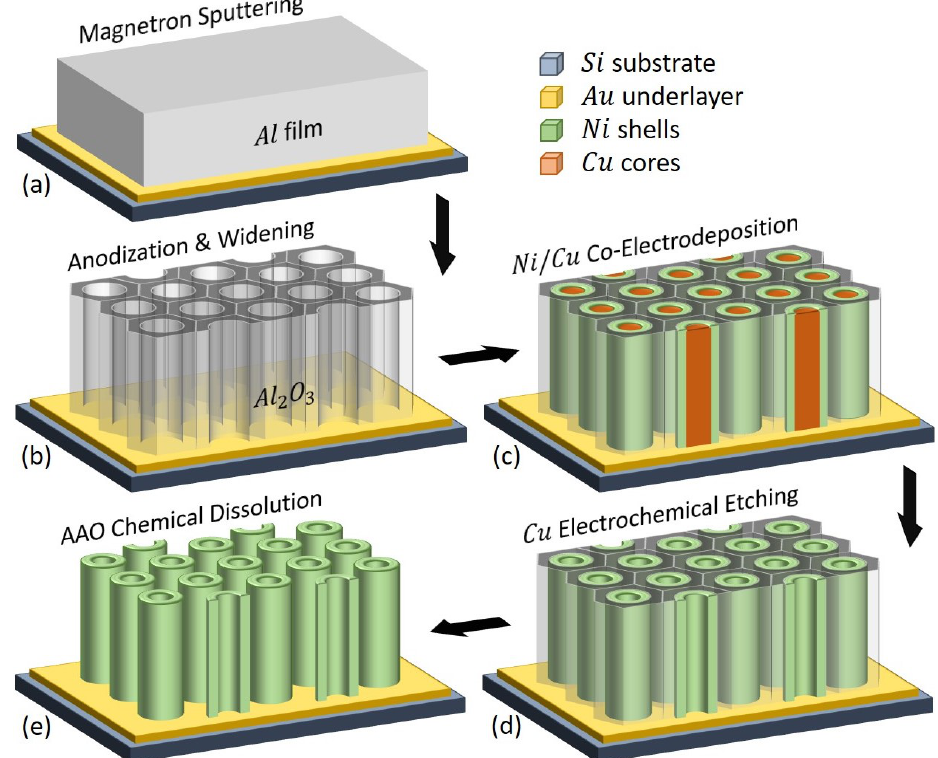
Figure 1. Schematic representation of the vertically-aligned Ni nanotubes (NTs) fabrication process. ( a ) Sputtering of the Au and Al layers on the Si substrate. The ultra-thin adhesion Ti film (as described in the text) was not represented for convenience. ( b ) Formation of the supported nanoporous anodic aluminum oxide (AAO) host through anodization and nanopores widening. ( c ) Cu/Ni core/shell nanowires (NWs) growth by co-electrodeposition (co-ECD). ( d ) Cu cores removal by electrochemical etching. ( e ) Chemical dissolution of the AAO template, revealing the Ni NTs perpendicularly-aligned to the Au/Si